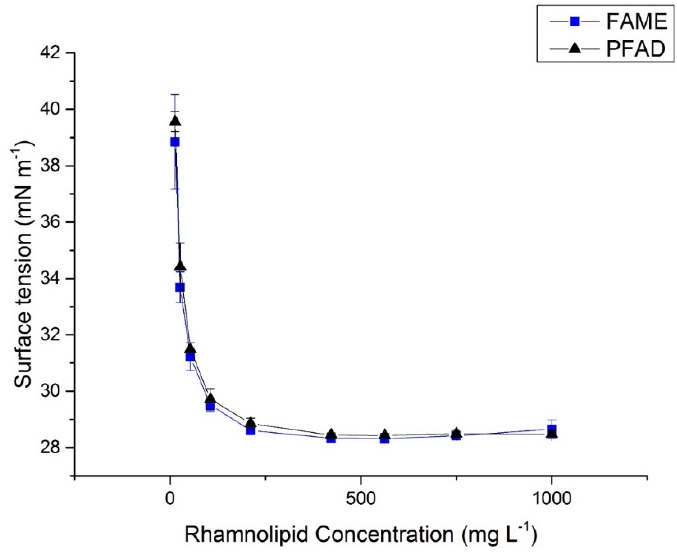
Figure 2. Surface tension reduction of rhamnolipid from PFAD and FAME.